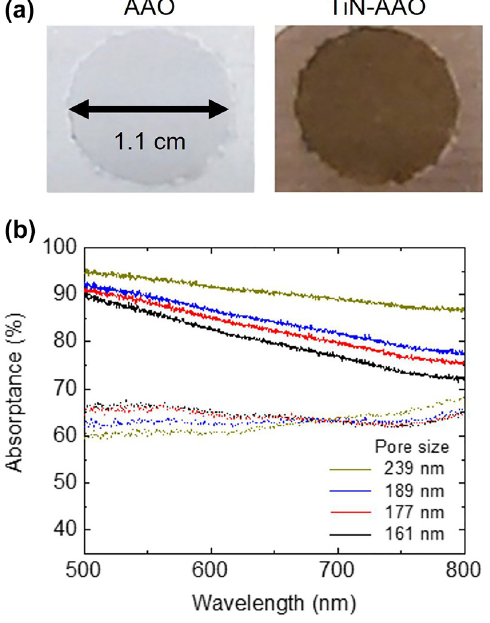
Figure 2: Optical images and absorptance of AAO and TiN-AAO samples.